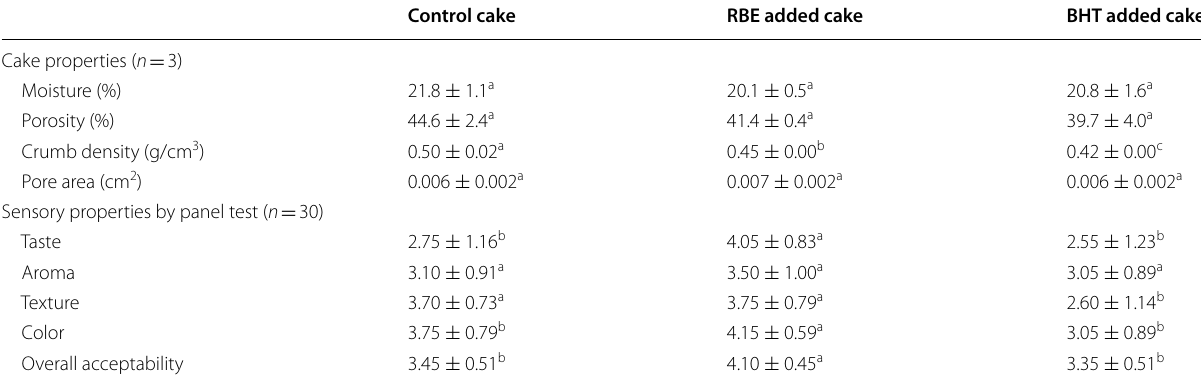
Data represent mean